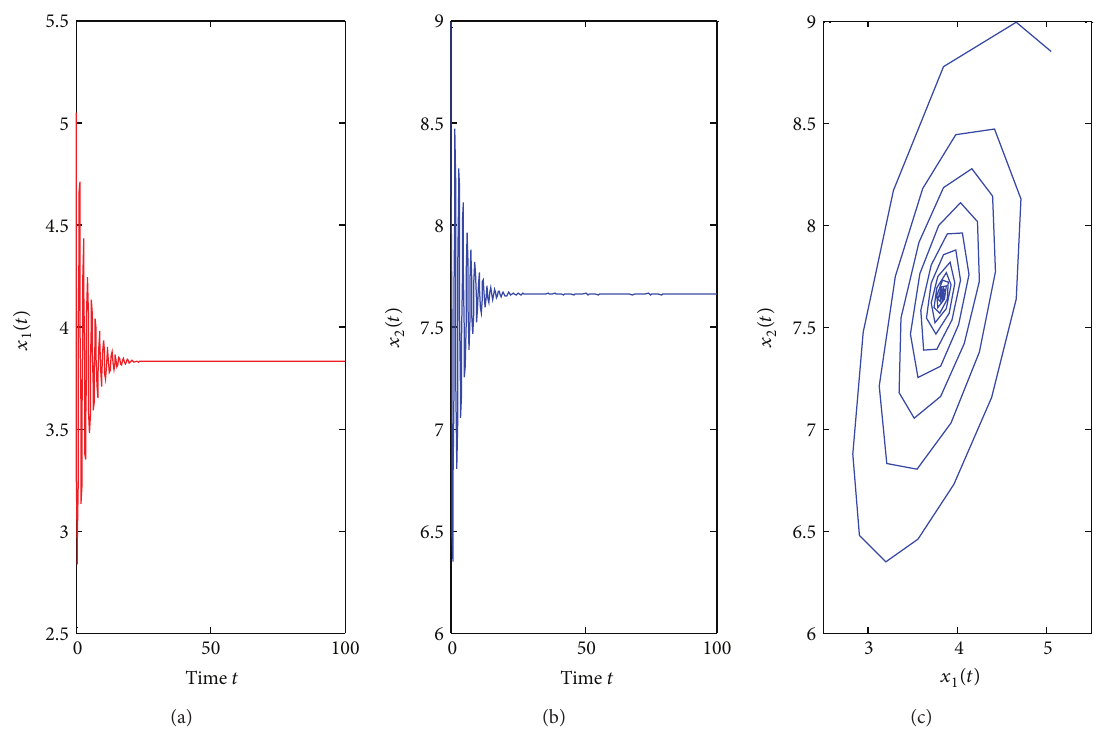
Figure 1: 𝐸 ∗ is asymptotically stable for 𝜏 1 = 0.350 < 𝜏 10 = 0.3788 .